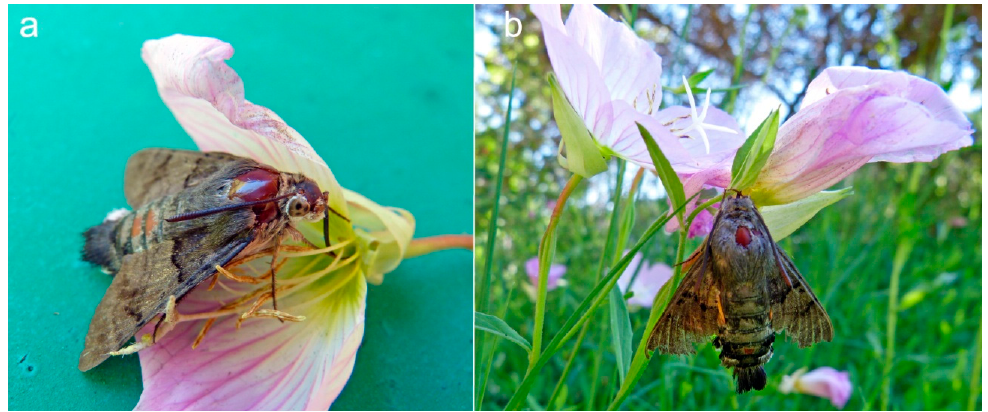
Figure 3. Two specimens of Macroglossum stellatarum stuck with their proboscides in the flowers of Oenothera speciosa ; the images show that their wings were very damaged in an effort to escape, and their thoraxes were widely ( a ) or partially ( b ) hairless. Photo credit: Andrea Bonifazi.